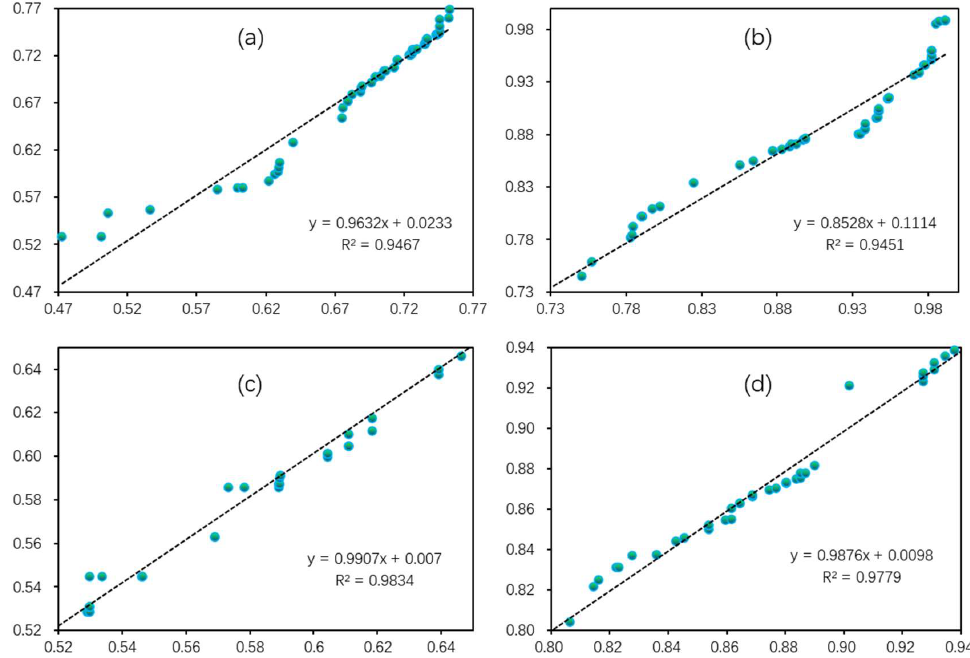
Figure 6. Scatter plots for the values of NDWI and MNDWI regression equations in 1998. ( a ) Landsat SR NDWI image; ( b ) Landsat SR MNDWI image; ( c ) Landsat TOA NDWI image; ( d ) Landsat TOA MNDWI image.